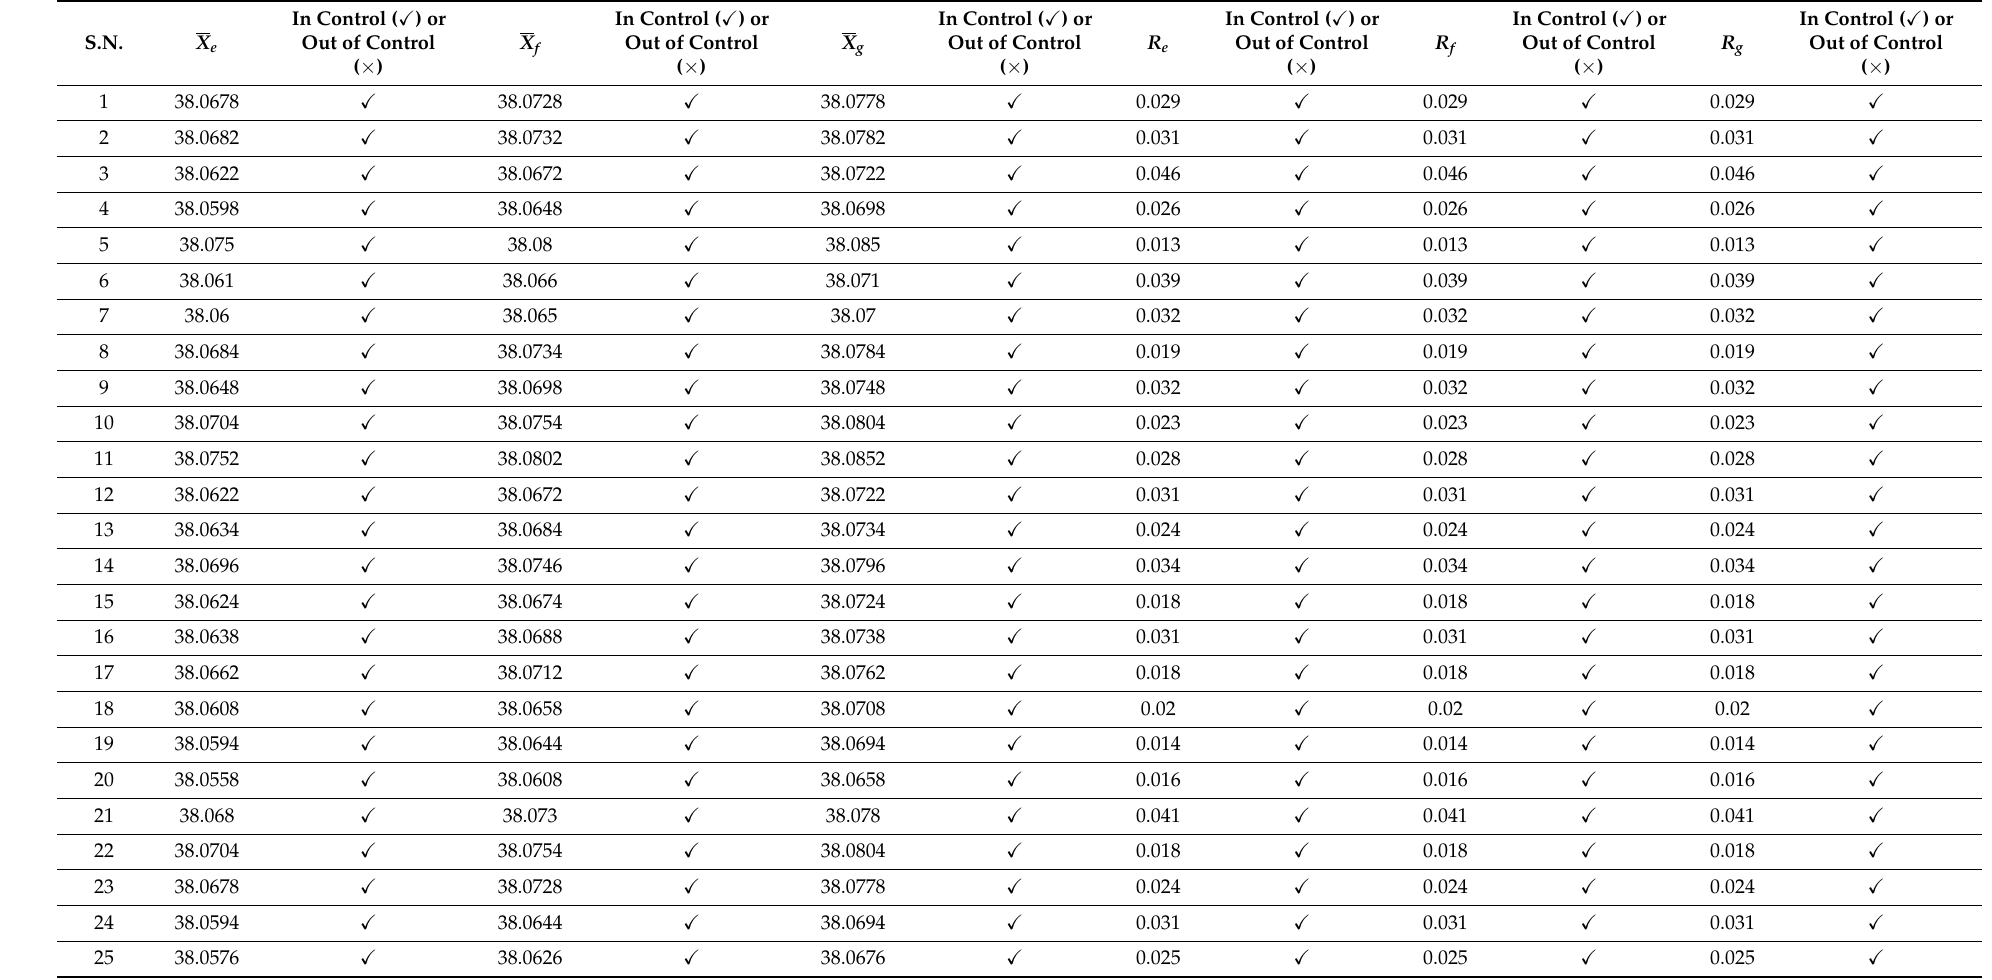
Table 7. Decision table for fuzzy X and R control limit with fuzzy C pk